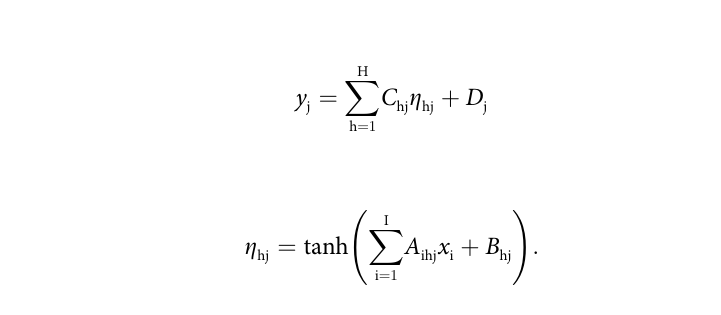
PLOS Computational Biology | https://doi.org/10.1371/journal.pcbi.1008275 October 7,